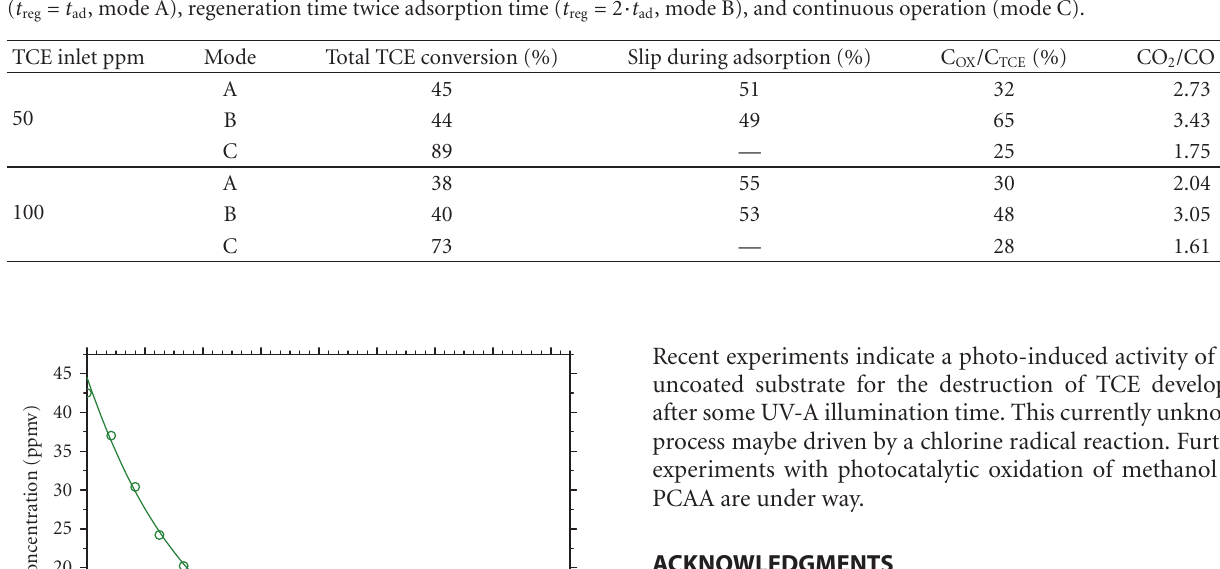
Table 3: Conversion e ffi ciency, slip during adsorption, oxidation ratio, and CO 2 -to-CO ratio for regeneration time equals adsorption time